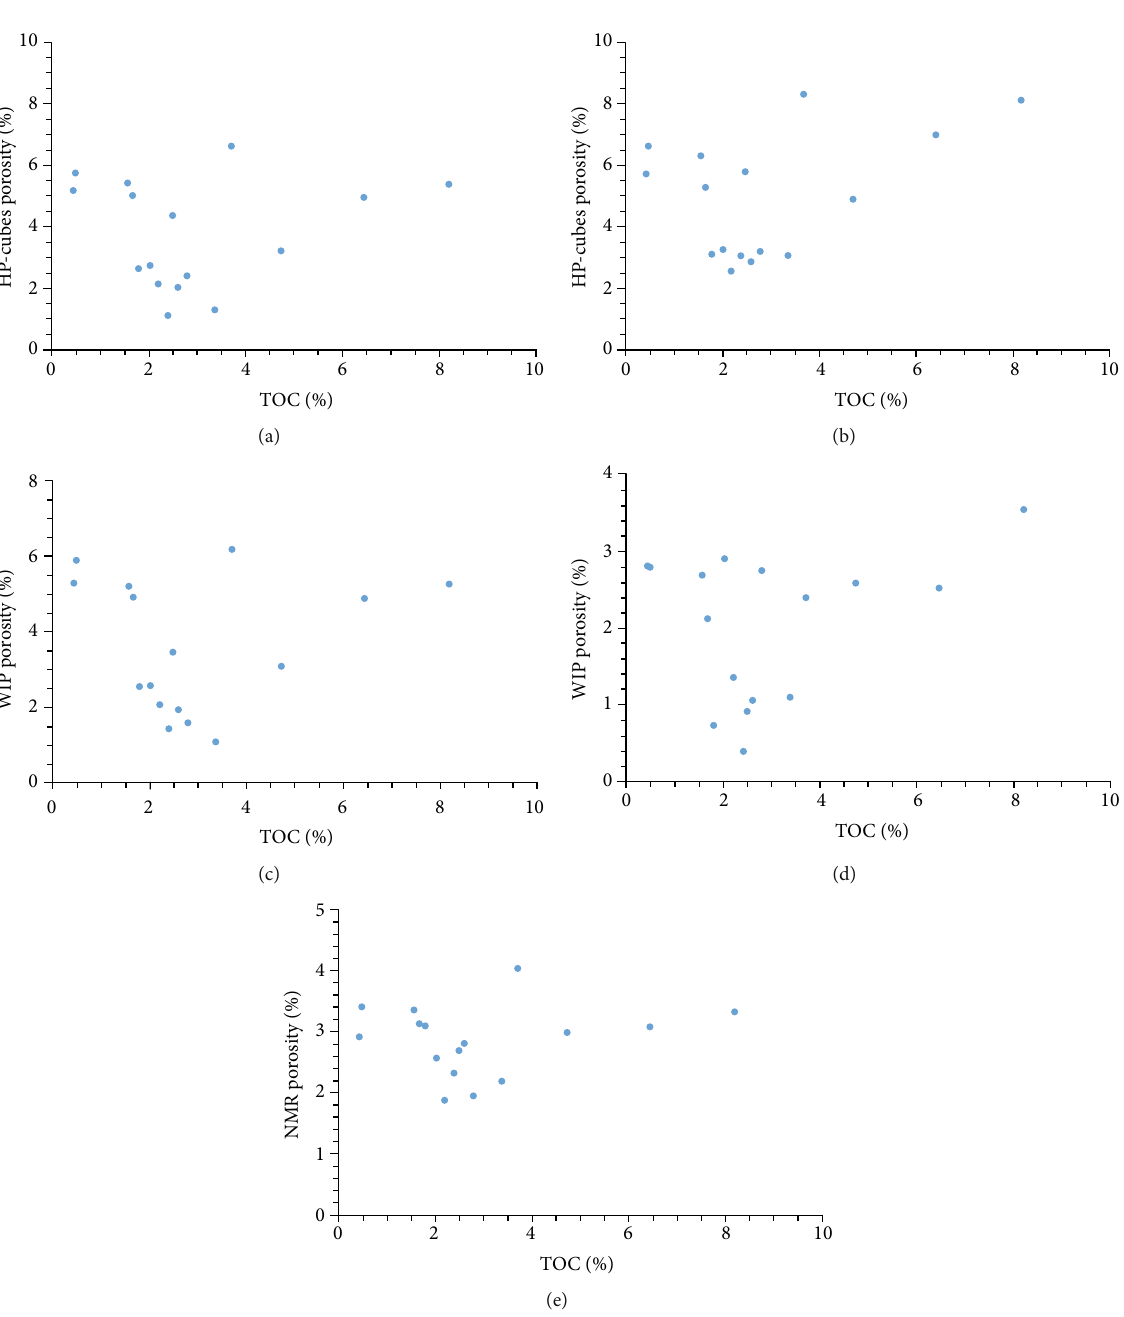
Figure 7: Relationships between TOC and porosities from di ff erent